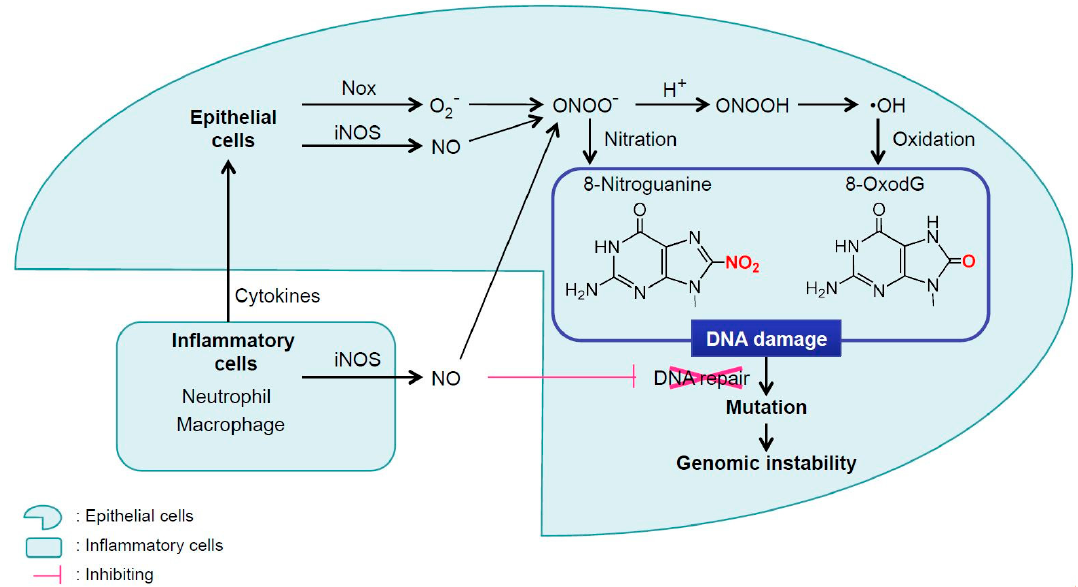
Figure 1. Mechanism for DNA damage in epithelial cells by inflammation. NO and O 2 − are produced during inflammation. Although NO is sufficiently long-lived to diffuse through the extracellular matrix, and enter the nucleus, O 2 − released by neutrophils or macrophages during inflammation is not sufficiently long-lived. Alternatively, inflammatory cells may use cytokines such as TNF- α to stimulate O 2 − formation via Nox in neighboring epithelial cells. NO, which is generated by especially iNOS, reacts with O 2 − forming ONOO − , which causes mutagenic DNA damage, such as 8-nitroguanine and 8-oxodG. NO and ROS can participate in inhibition of a number of DNA repair enzymes, which enhances mutations, leading to genomic instability.